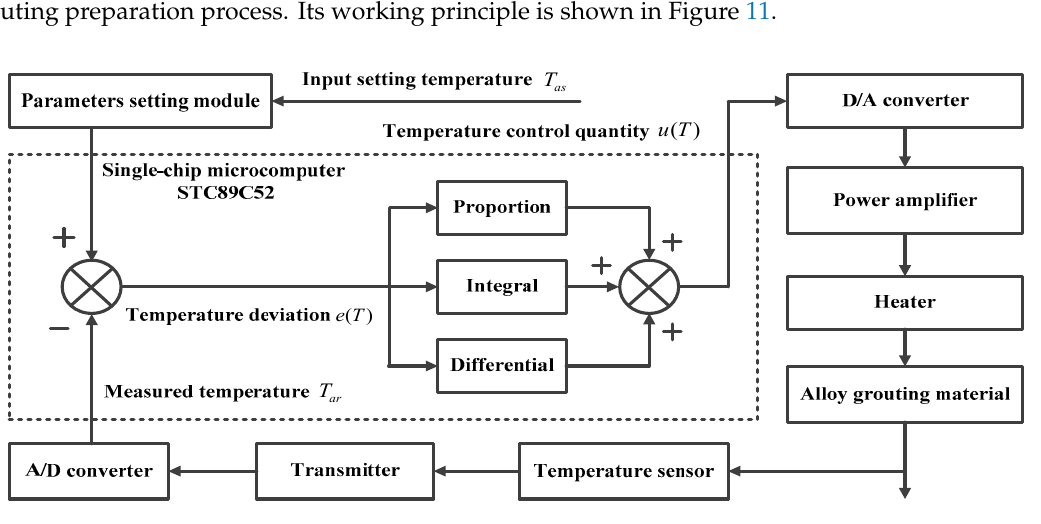
Figure 10. Block diagram of the control device and its functions.